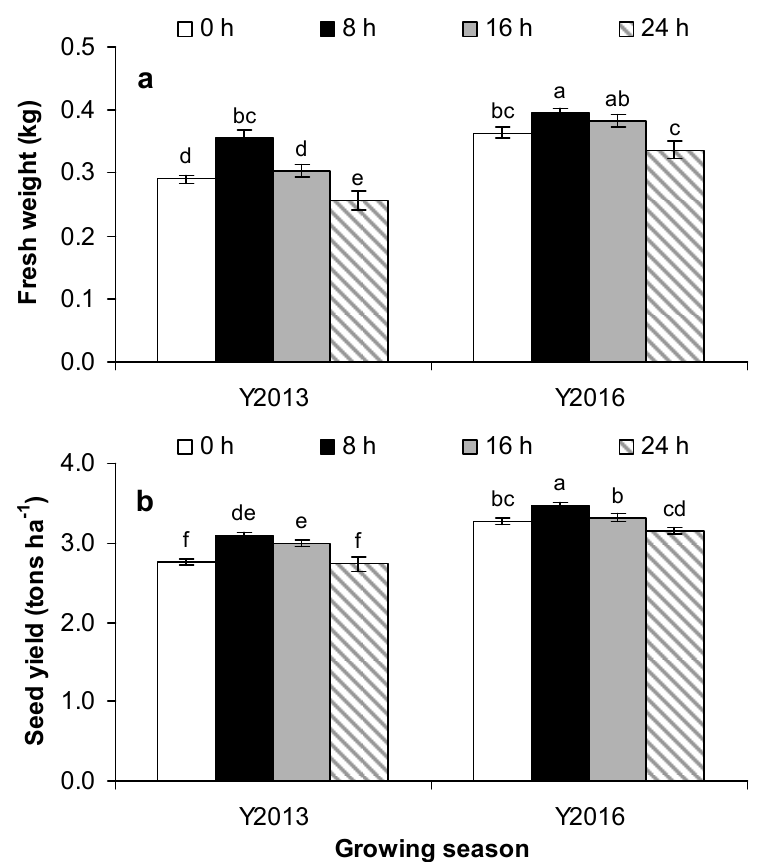
Figure 3. Fresh weight per m of row (kg) ( a ) and seed yield (tons ha − 1 ) ( b ) (di ff erent letters show statistically significant di ff erences according to LSD test at p < 0.05, vertical lines denote standard errors of